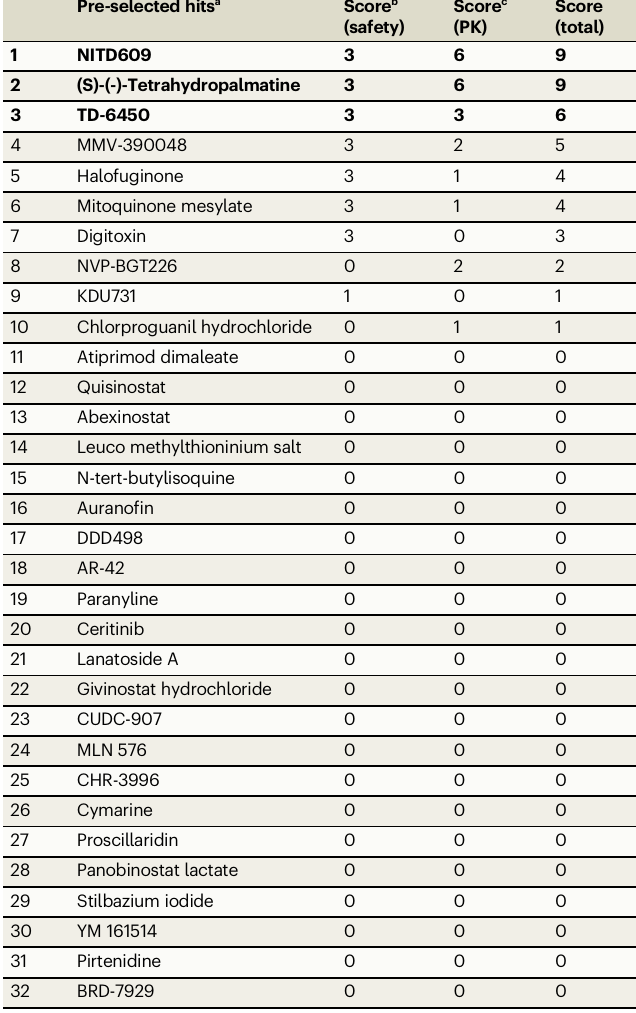
The3 con fi rmed hitsareinbold. a 44ofthe76DRA-con fi rmedhits fromtheReFrame library(Fig.1) were